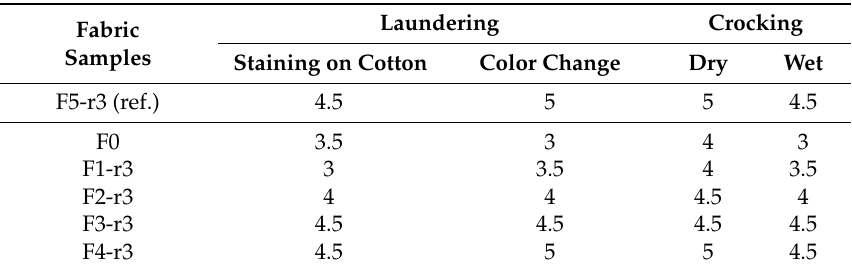
Table 3. Colorfastness of fabrics rinsed with freshwater and treated